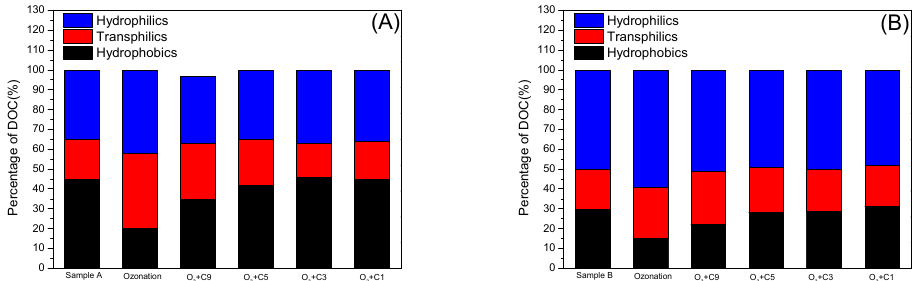
Figure 4. The proportions of hydrophilic/hydrophobic components in dissolved organic matter of sample A ( A ) and sample B ( B ).